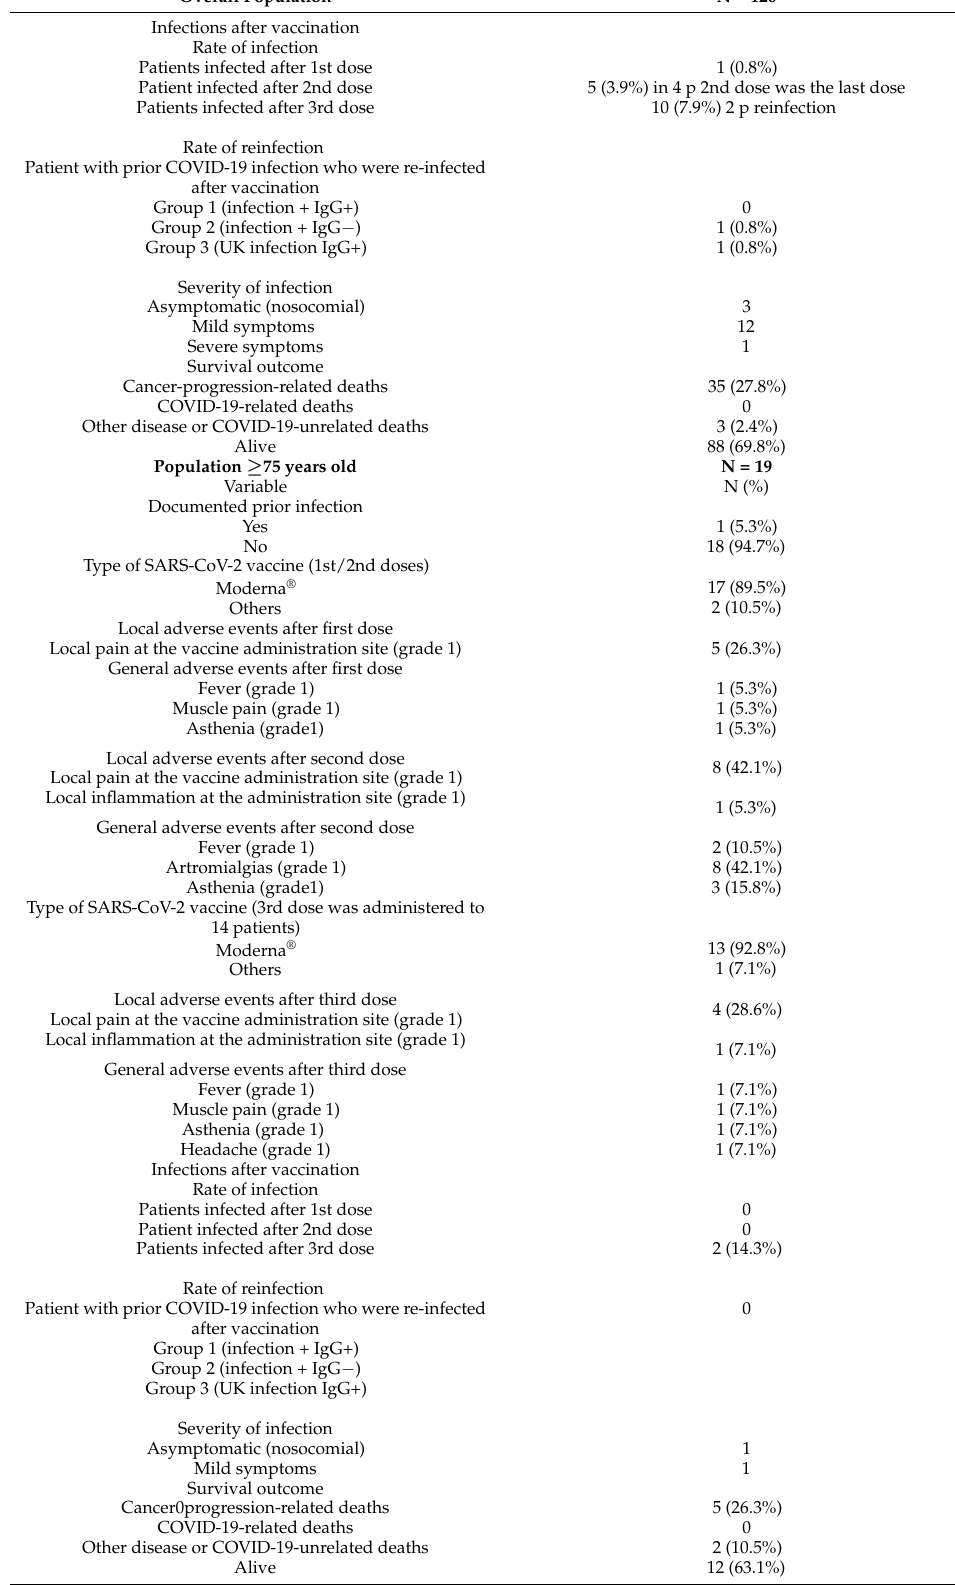
Table 2. Cont. Overall Population N = 126 Infections after vaccination Rate of infection Patients infected after 1st dose Patient infected after 2nd dose Patients infected after 3rd dose Rate of reinfection Patient with prior COVID-19 infection who were re-infected after vaccination Group 1 (infection + IgG+) Group 2 (infection + IgG − ) Group 3 (UK infection IgG+) Severity of infection Asymptomatic (nosocomial) Mild symptoms Severe symptoms